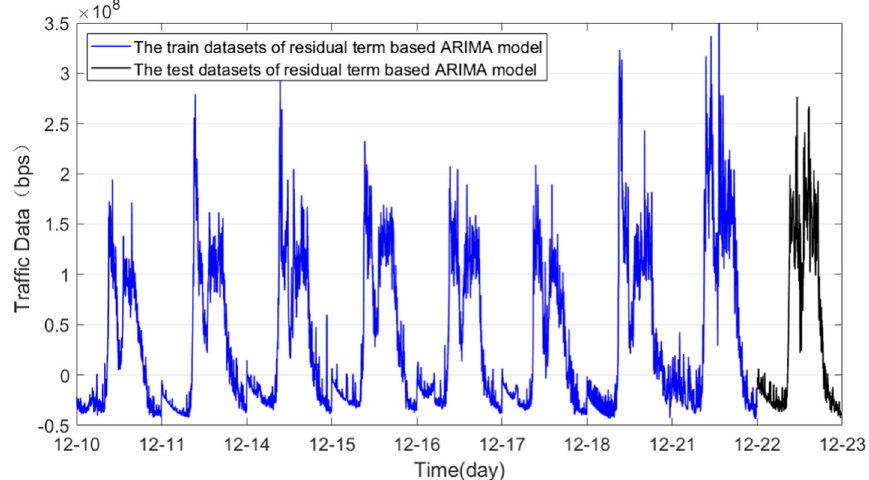
Fig. 9 Residual term based on ARIMA model